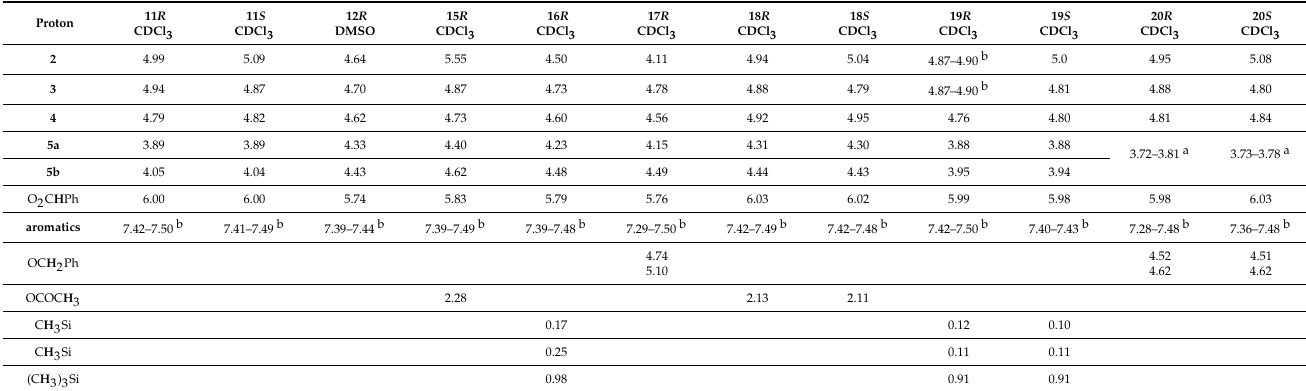
Table 1. 1 H NMR chemical shifts (ppm) of R and S epimers of 11 , 18 – 20 and R epimers of 12 , 15 – 17.